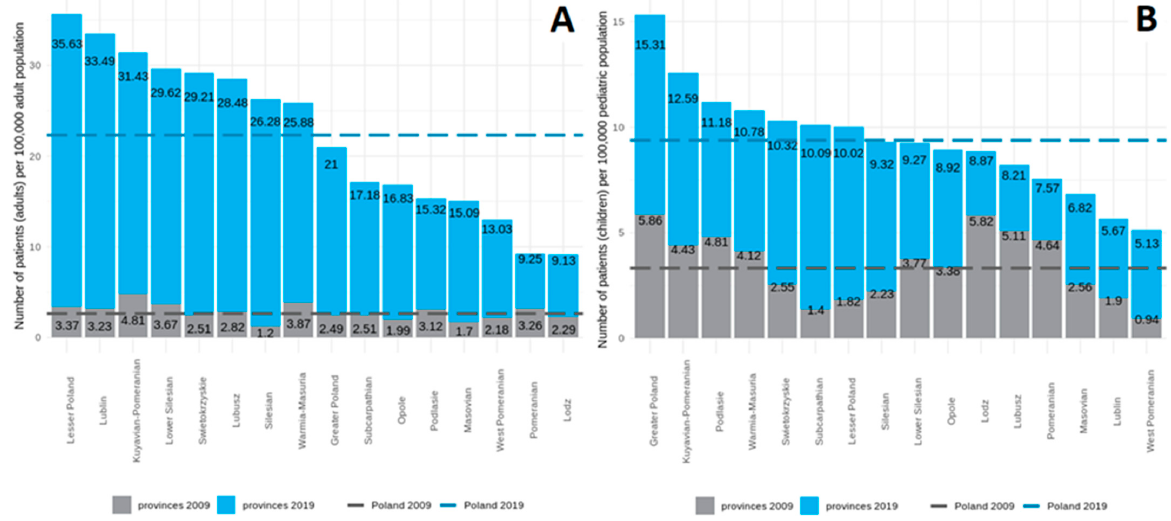
Figure 5. Prevalence of HMV (( A ) adults, ( B ) children) in individual provinces in 2009 (grey) and in 2019 (blue). The horizontal line represents the average for Poland in 2009 (bottom line) and 2019 (top line).